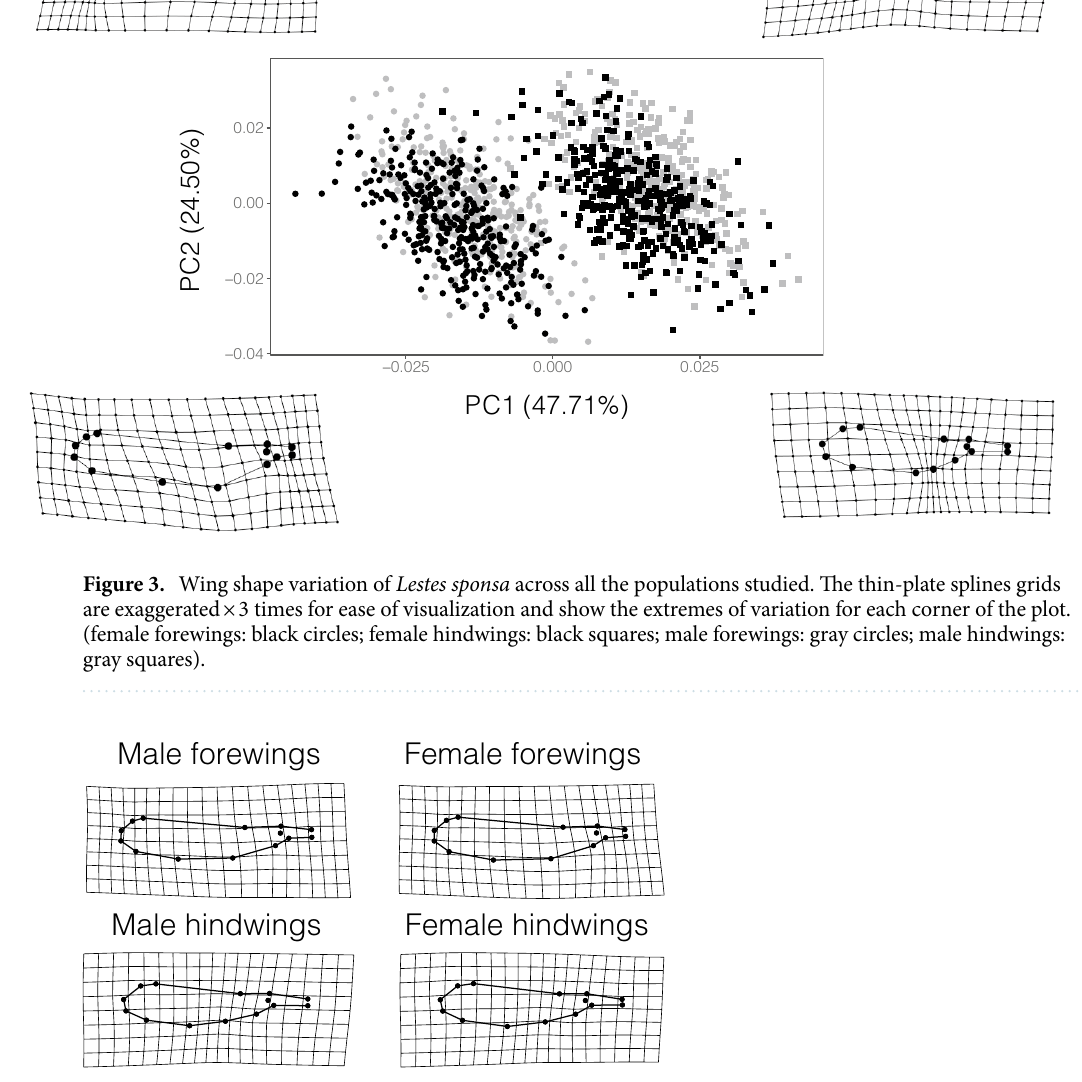
Figure 4. Thin-plate splines depicting the wing shape differences between males and females and fore- and hindwings of Lestes sponsa . The grids are exaggerated × 3 times for ease of